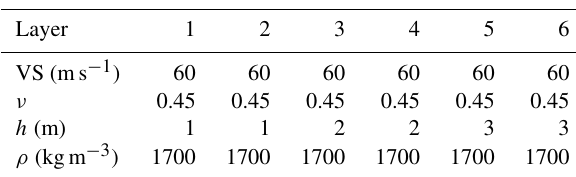
Table 3. Parameters of the initial model for the inversion in the Pijnacker